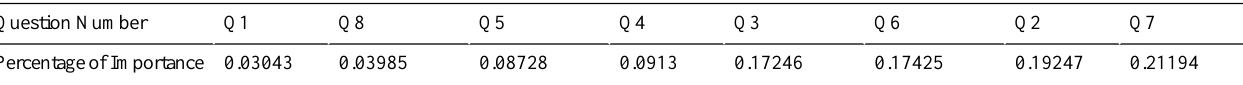
Table 4. Importance of the eight dynamic ecological momentary assessment (EMA-D) questions for the random forest classifier prediction. Question 1 (Q1): Did you perceive the tinnitus right now? (yes or no); Q2: How loud is the tinnitus right now? (slider); Q3: How stressful is the tinnitus right now? (slider); Q4: How is your mood right now? (manikins); Q5: How is your arousal right now? (manikins); Q6: Do you feel stressed right now? (slider); Q7: How much did you concentrate on the things you are doing right now? (slider); and Q8: Do you feel irritable right now? (yes or